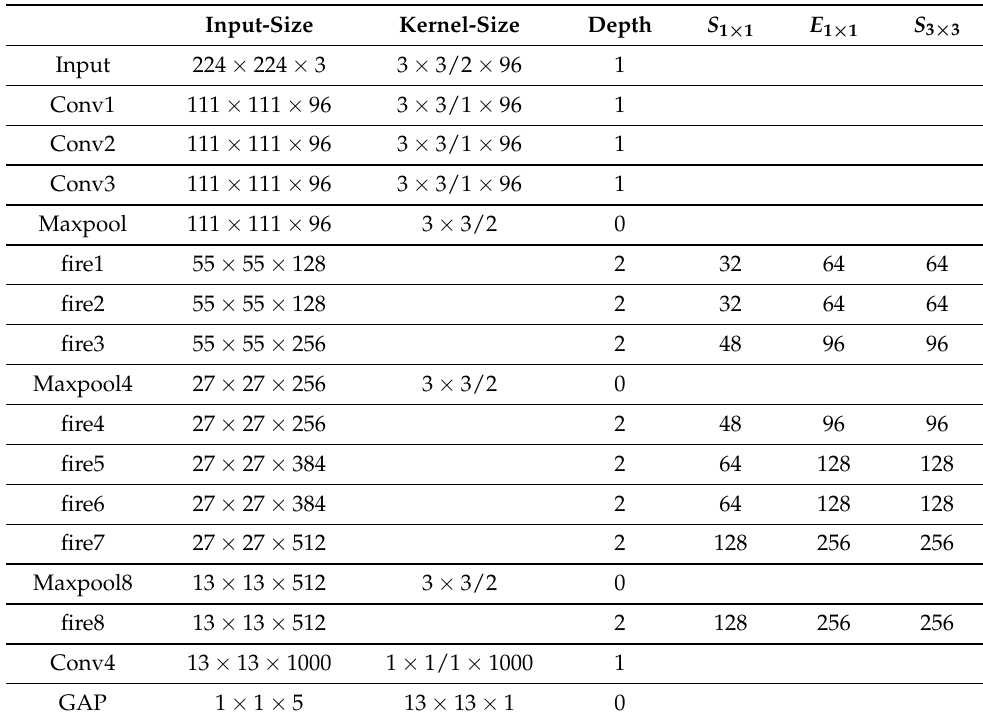
Table 3. Specific structure of the S-ResNet classification model.